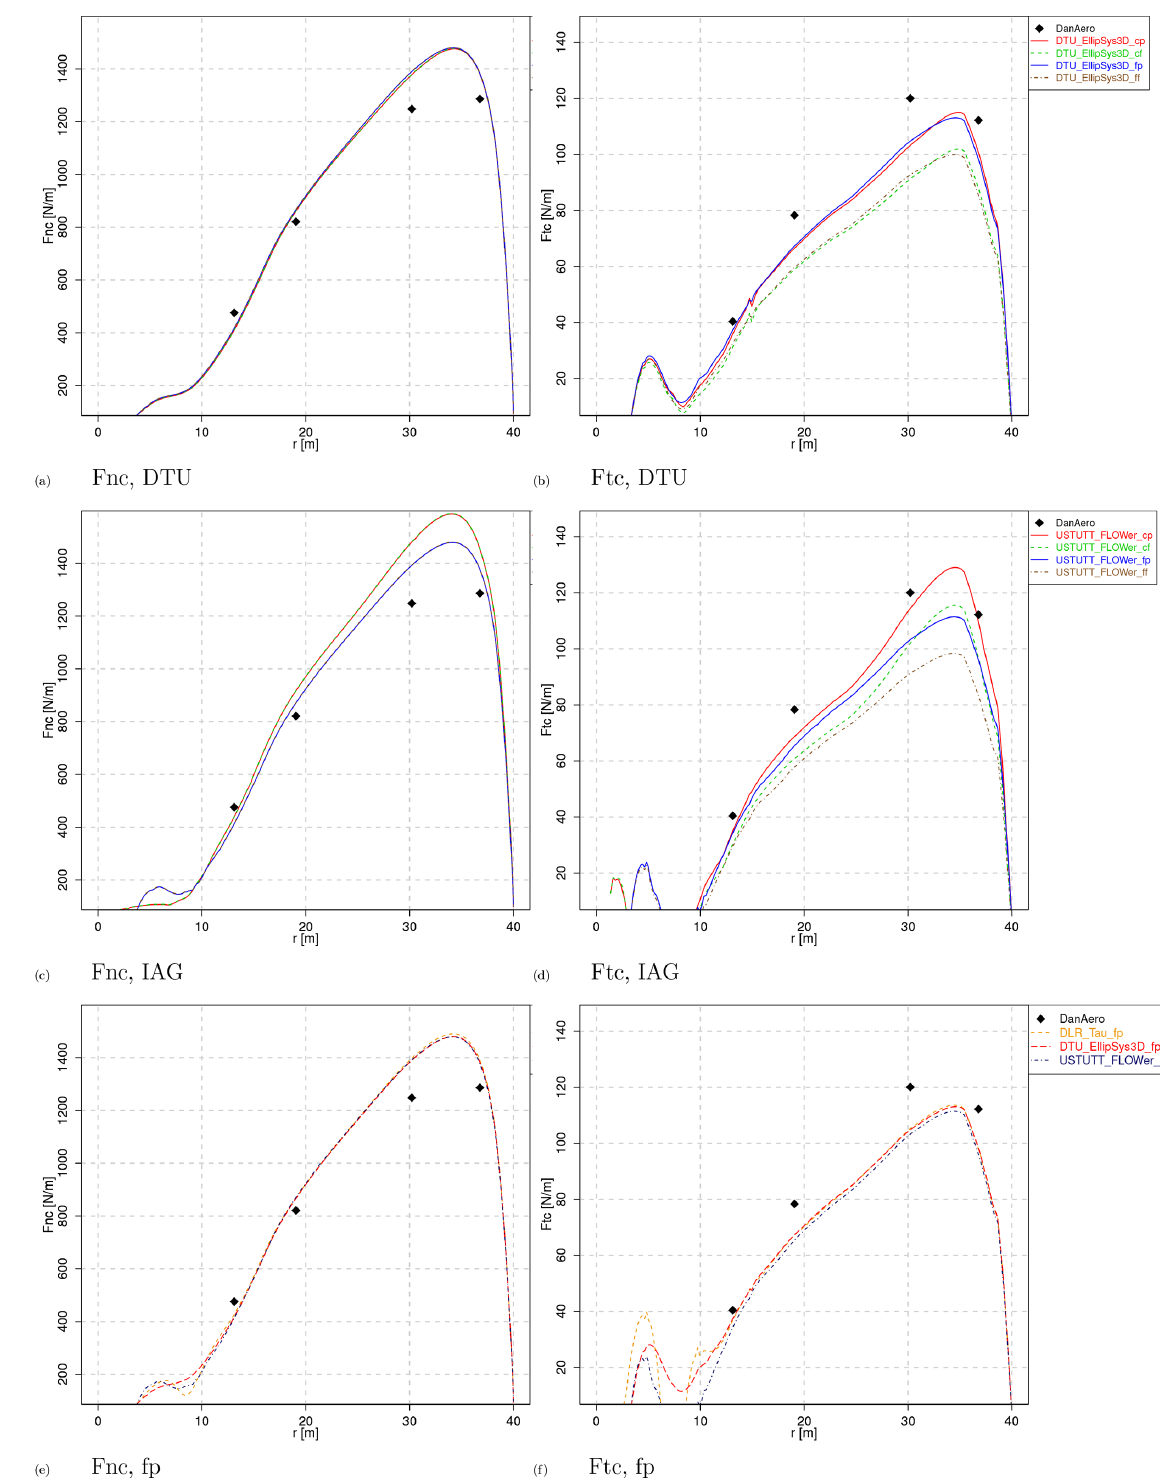
Figure 5. Effect of CFD sensitivity studies on predicted loads for Case IV.1.1.